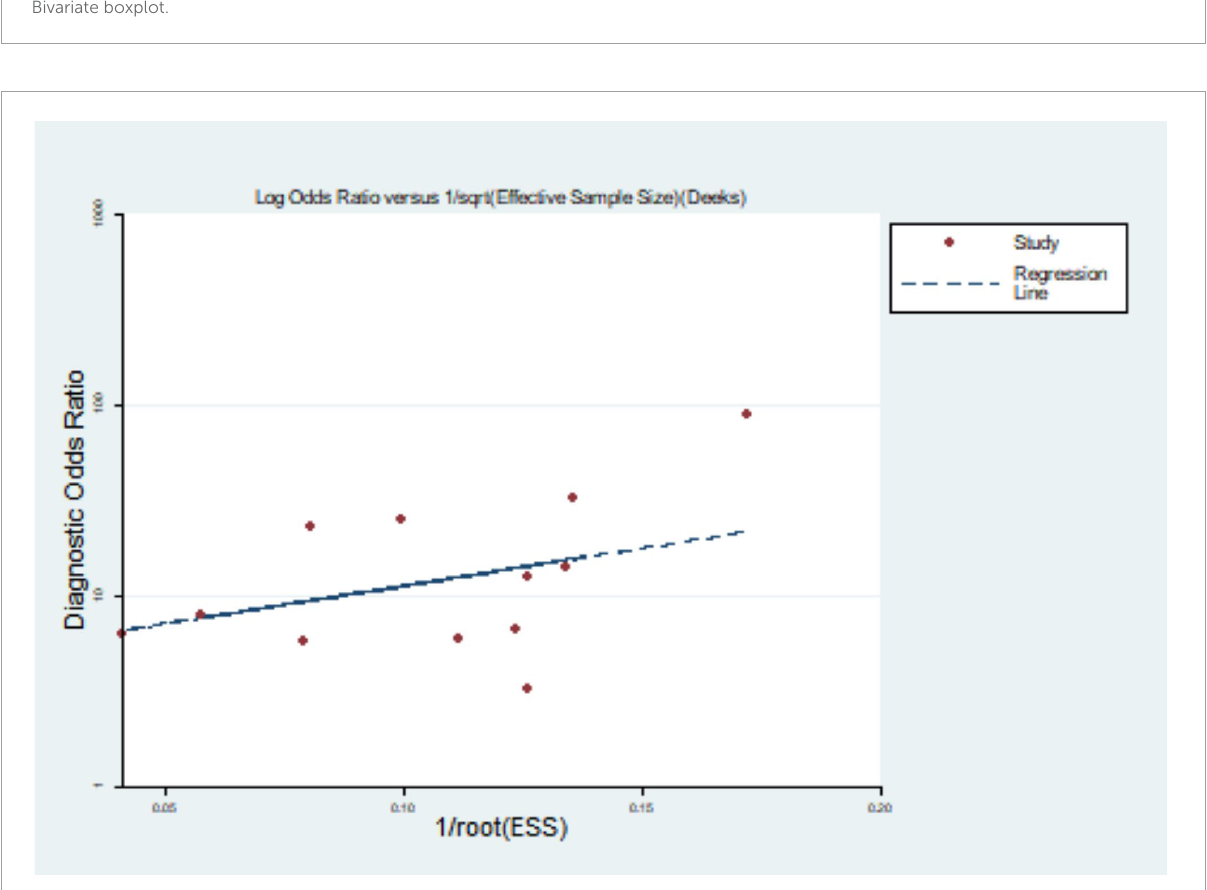
FIGURE8 Deek’s funnel